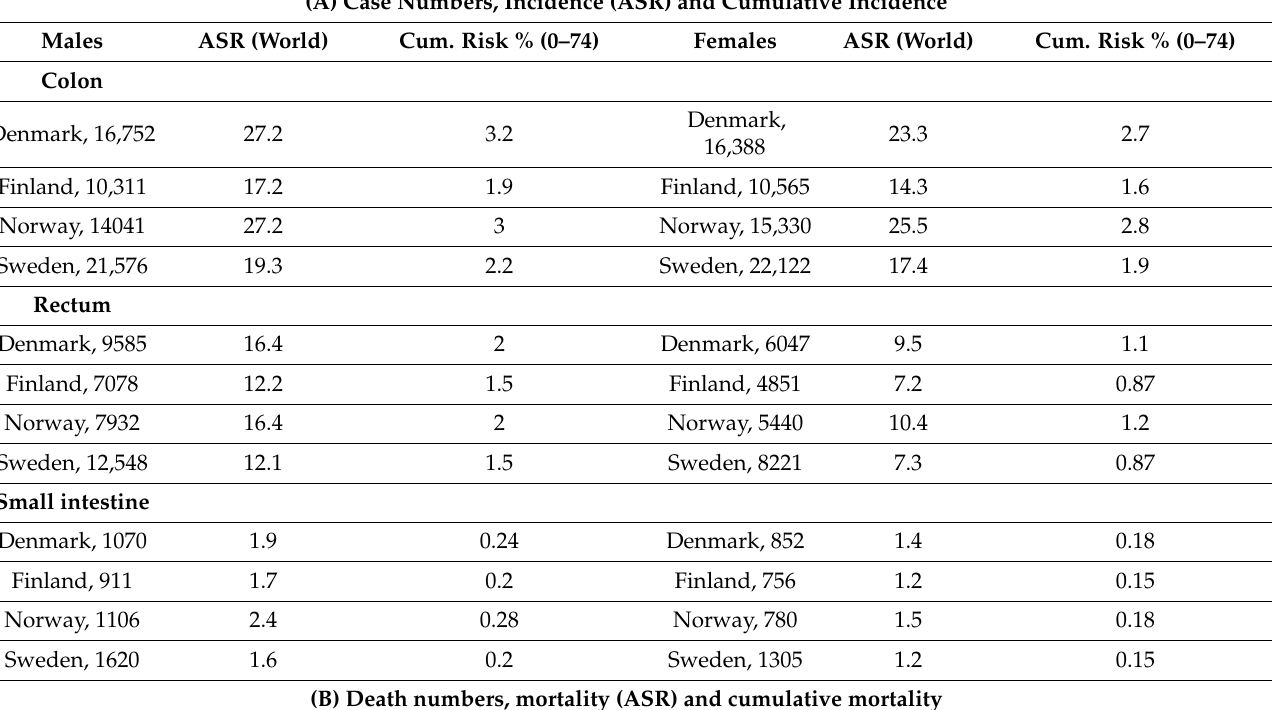
Table 1. Incidence (A) and mortality (B) in colon, rectal and small intestine cancers from 2011 to 2020, separately for males (left part) and females (right